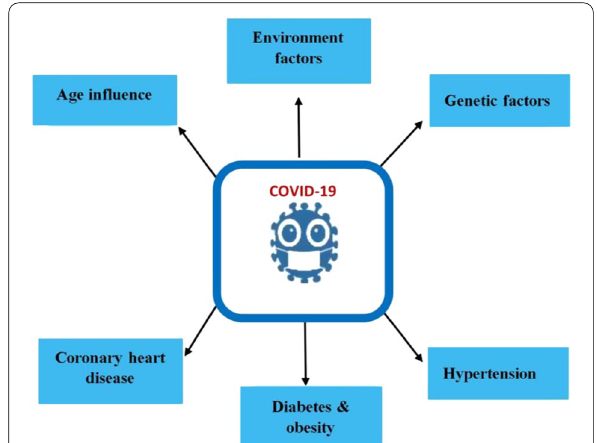
Fig. 3 Multiple risk factors of